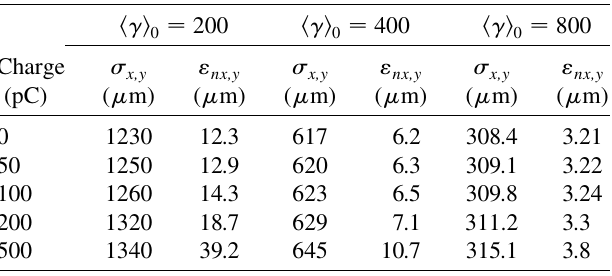
TABLE I. Transverse size, (cid:7) femtosecond electron bunch, after 50 cm propagation in vacuum, depending on the mean energy, h (cid:4) i bunch. The initial bunch parameters are the same as for Fig.